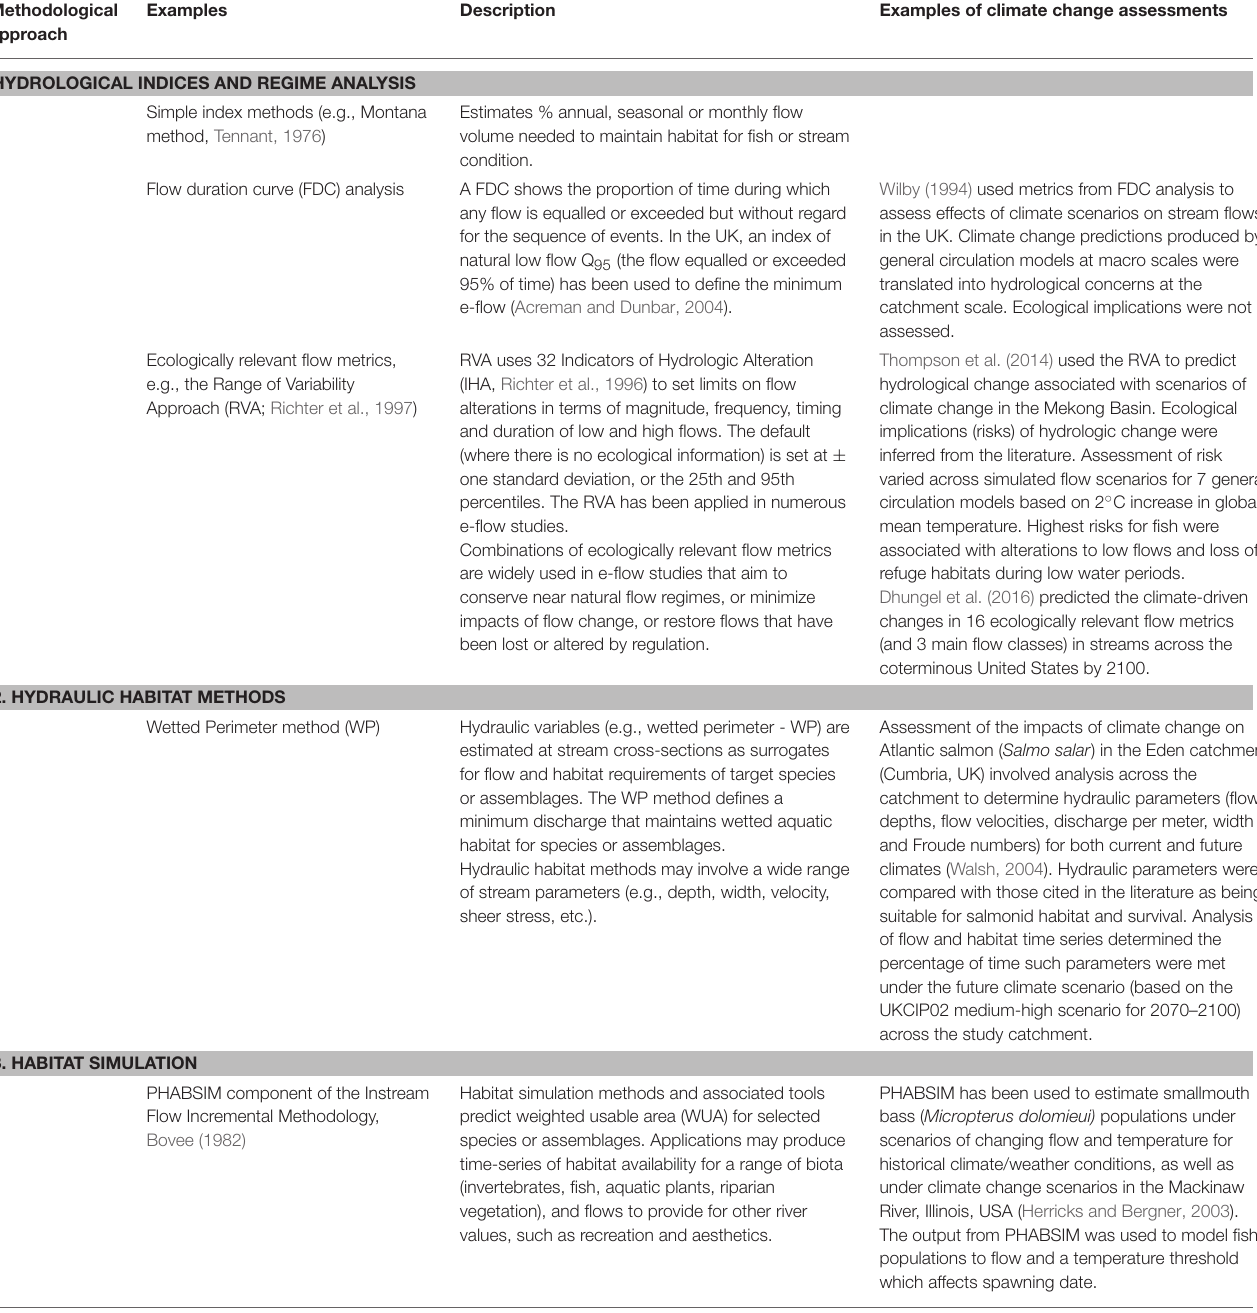
TABLE 1 | Four main methodological approaches used to design environmental flows with examples of relevant climate change assessments (for details of methods and case studies, see Tharme, 2003; Arthington, 2012; Linnansaari et al.,